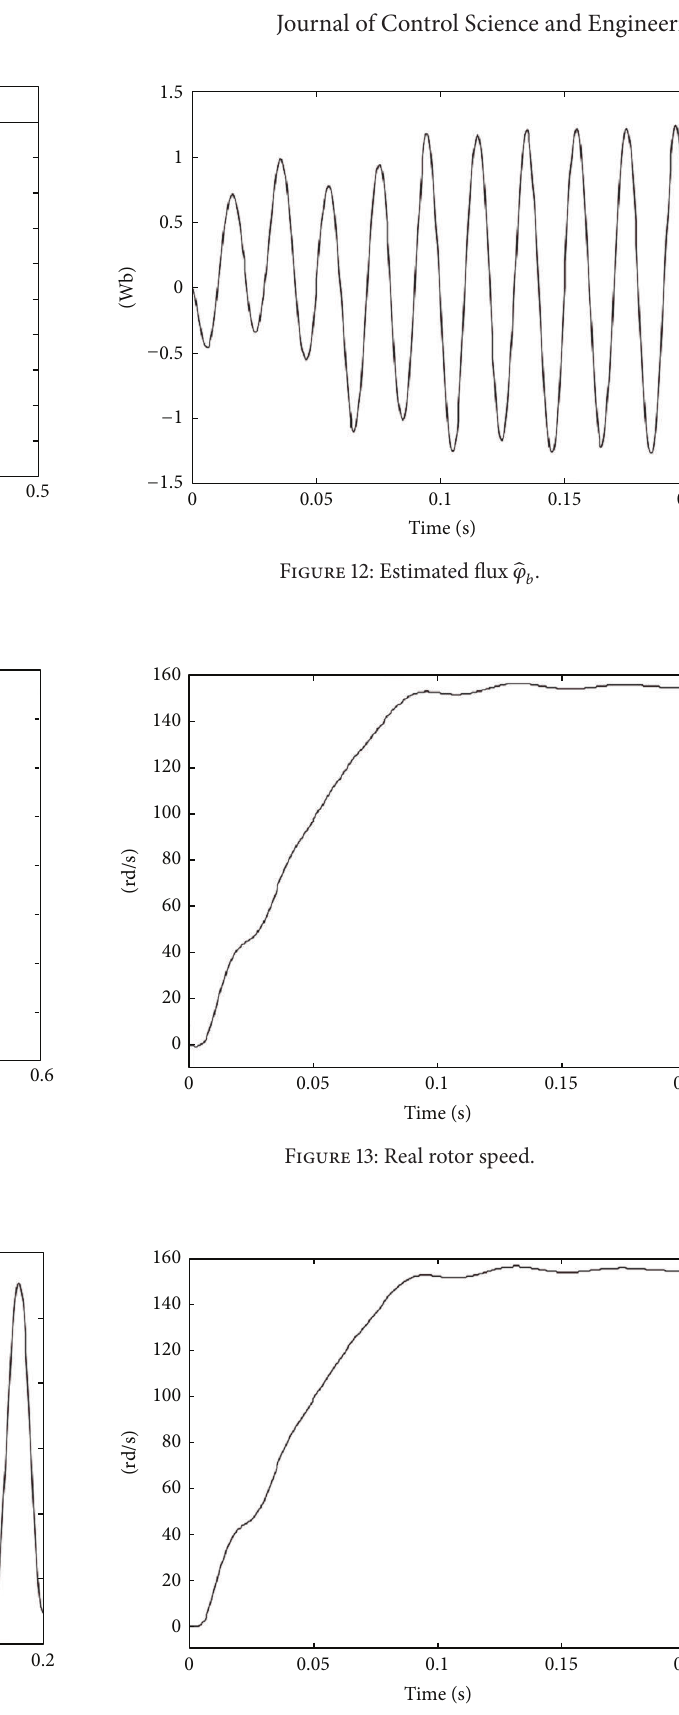
Figure 11: Estimated flux ̂𝜑 𝑎 .